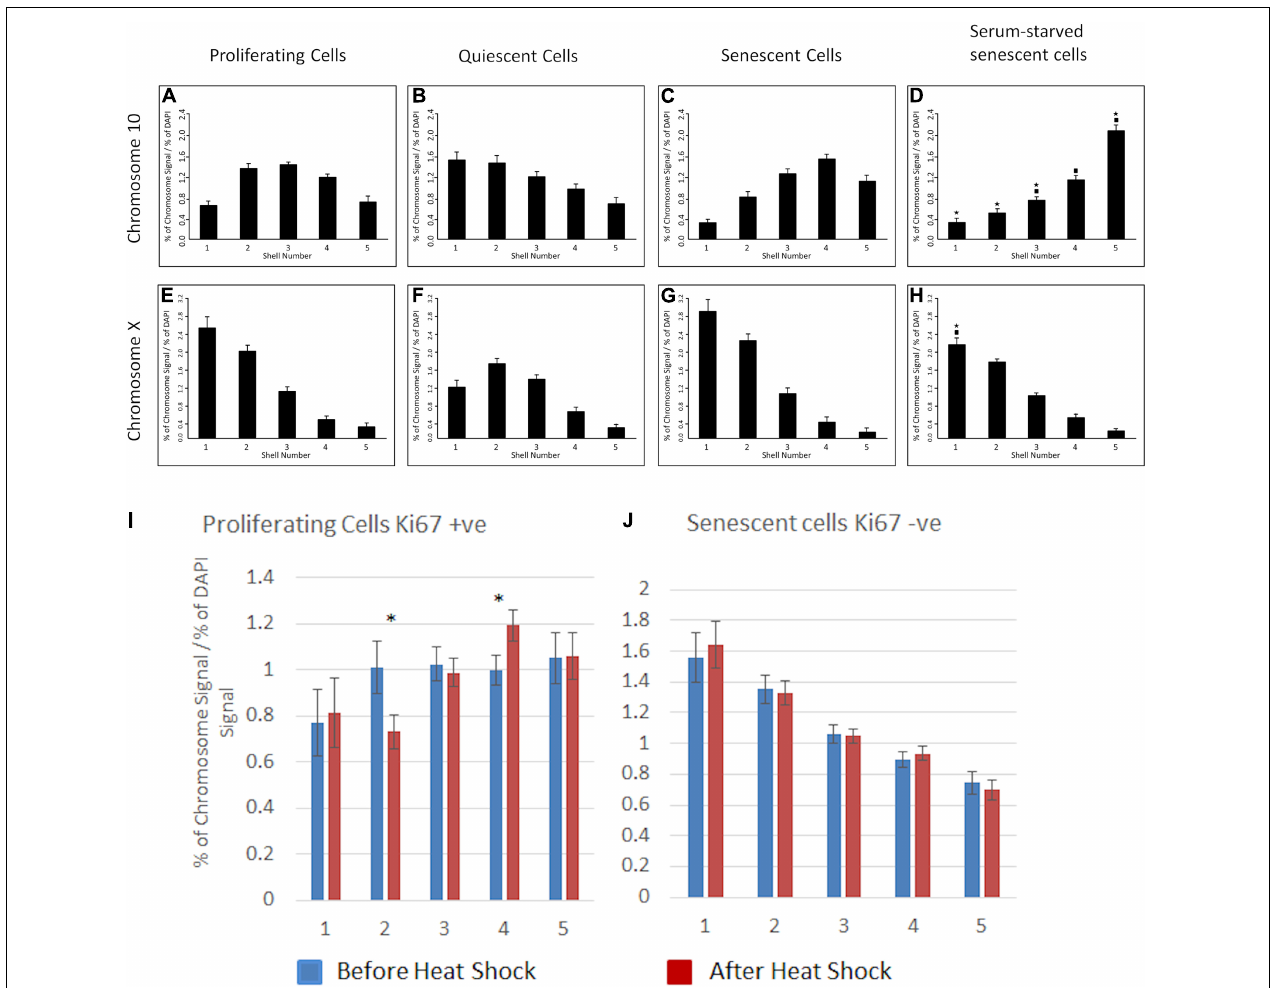
FIGURE 6 | Chromosomes 10, X or 11 do not relocate to new nuclear locations in senescent nuclei upon serum removal or heat shock. For senescent cells HDFs were grown in 10% NCS until the culture became mostly comprised of non-confluent senescent cells as determined by the absence of anti-pKi-67. Young proliferating cells were collected from early passage cultures where anti-Ki67 staining was in over 65% of cells. The cultures were serum-starved by incubation with 0.5% NCS for 7 days (chromosome 10 and X) or subjected to a heat-shock (42 ◦ C, 1 h, chromosome 11). Positions of chromosomes 10 and X were determined using 2D-FISH erosion analysis and anti-Ki67 staining to differentiate between proliferating and senescent cells. Chromosome 10 (A–D) , chromosome X (E–H) , chromosome 11 (I,J) . Panels (A–H) : The asterisks indicate statistical difference ( p < 0.05), as assessed by Student’s t -test, to the normal quiescent cells. The filled-in squares indicate statistical difference ( p < 0.05) to normal senescent cells grown in 10% serum. In panels (I,J) asterisks indicate statistical difference ( p < 0.05), as assessed by Student’s t -test for before and after